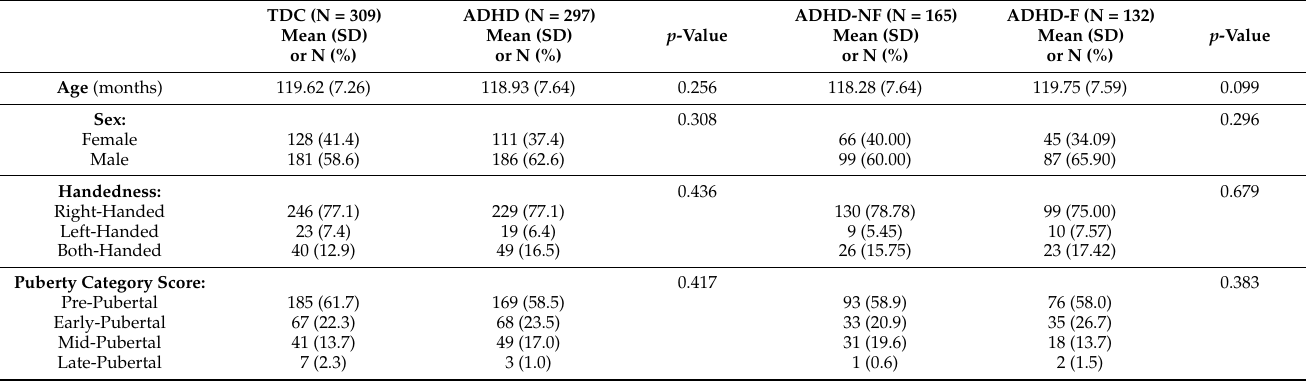
Table 1. Demographic and clinical characteristics comparisons between groups of controls and ADHD probands, and between ADHD-F and ADHD-NF